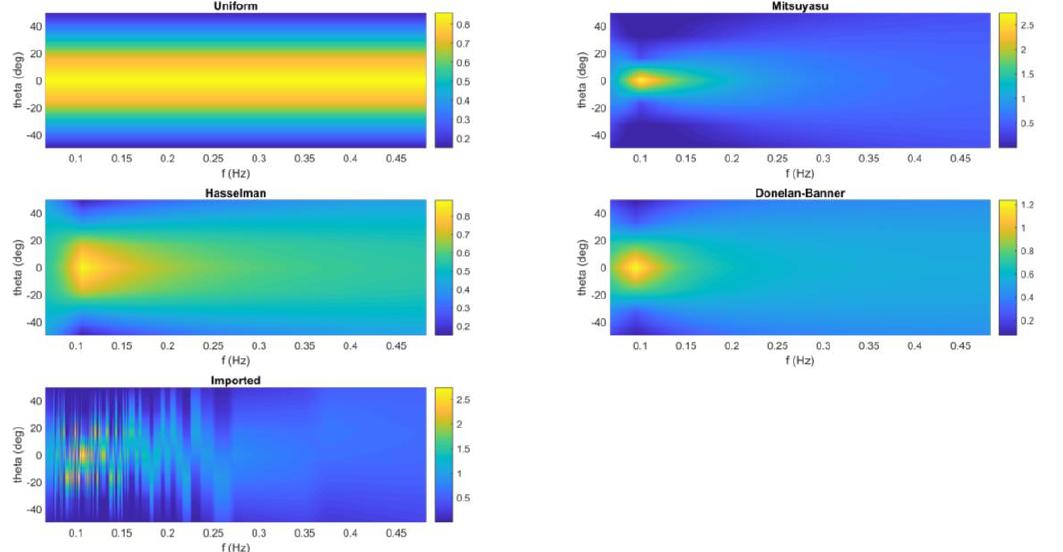
Fig. 2: Frequency-directional distributions compared in this work. These are the uniform, the Mitsuyasu, the Hasselman, the Donelan-Banner and a user imported option. An example for the user option is shown and it is the Mitsuyasu with a random mean wave direction obtained for each frequency range